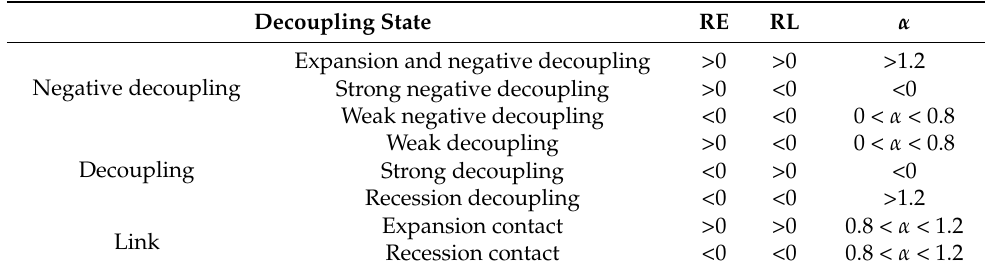
Table 1. Definition of degree of